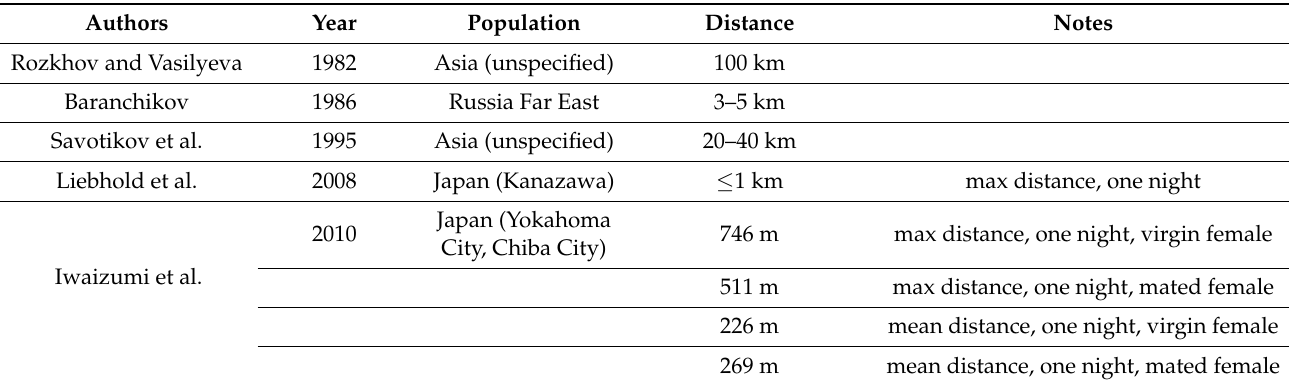
Table 2. Flight distances of gypsy moth populations in China, Japan, and Eastern